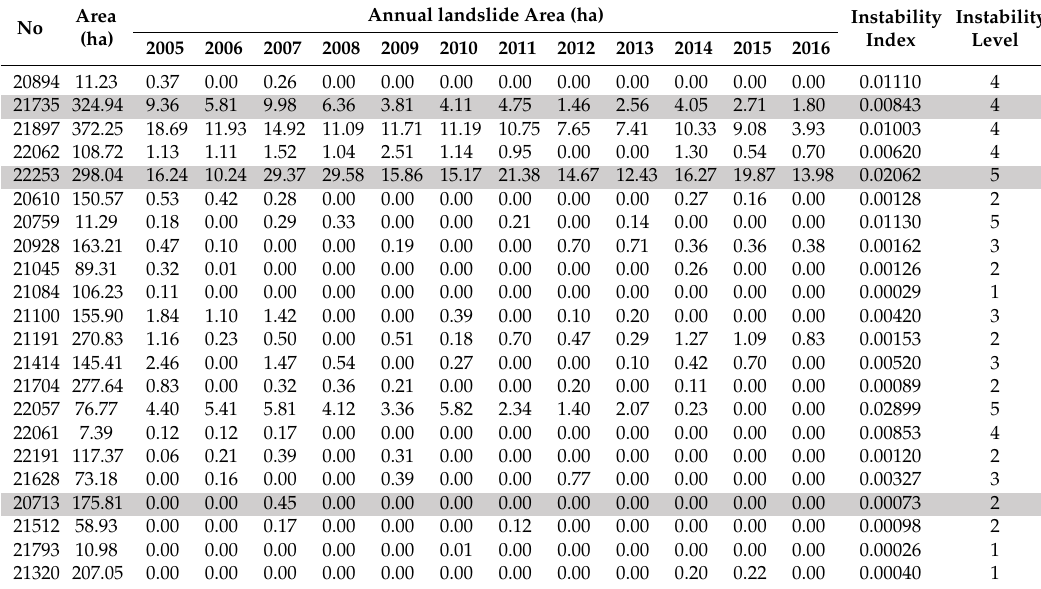
Table 3. Annual landslide area, instability index, and level of instability of 22 optimum sub-watersheds in the Qingquan watershed in Wufeng Township, Hsinchu County.